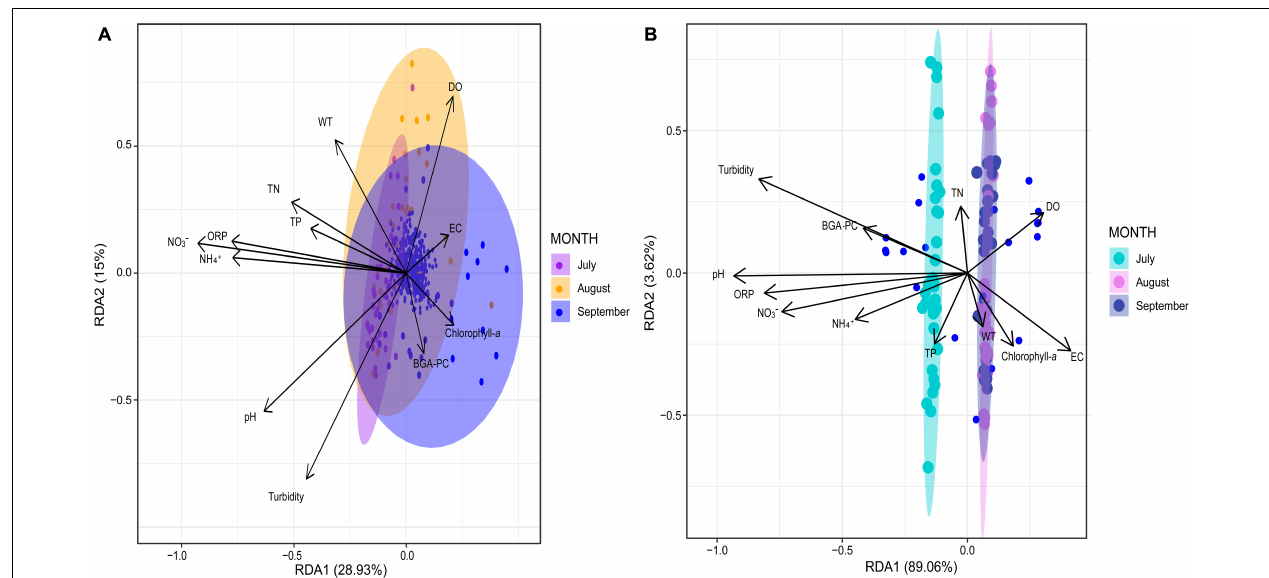
FIGURE 6 | Biplot of the results of the redundancy analysis (RDA). (A) RDA regarding bacterial composition and physicochemical variables by sampling month. (B) RDA regarding functional composition and physicochemical variables by sampling month. Water temperature (WT), dissolved oxygen (DO), pH, electrical